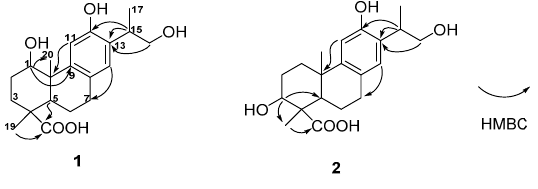
Figure 2. Key HMBC correlations of compounds 1 and 2 .